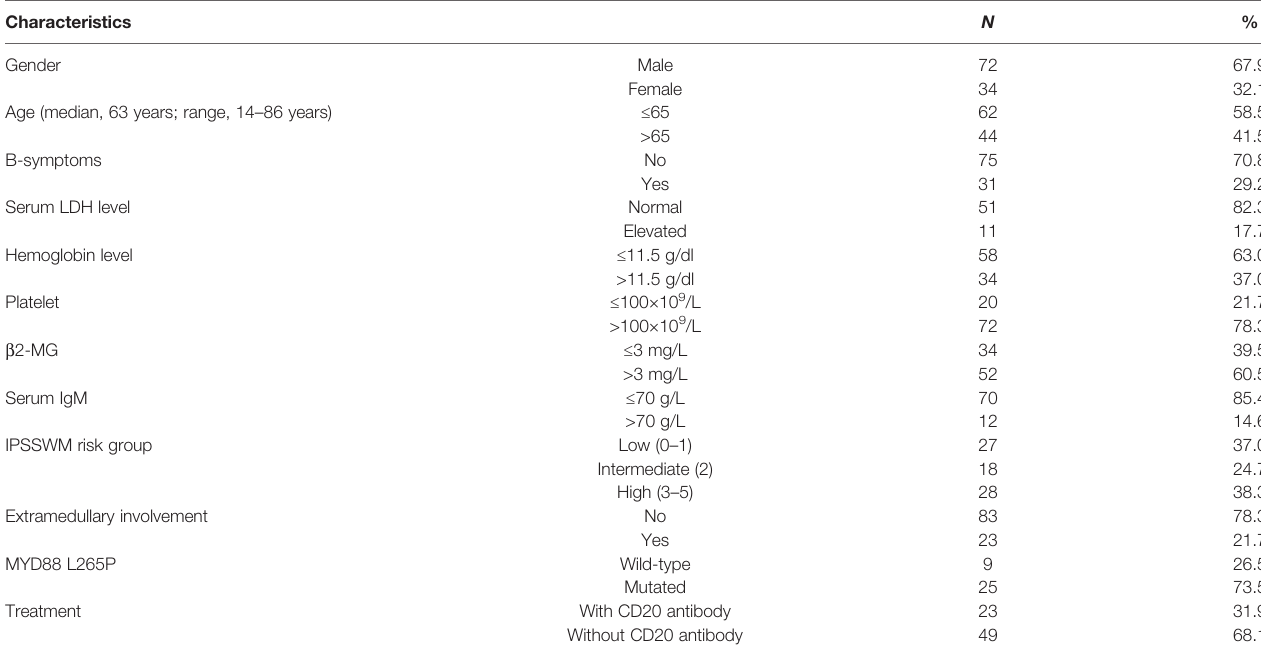
TABLE 1 | Clinical and biological characteristics of Waldenström macroglobulinemia/lymphoplasmacytoid lymphoma (WM/LPL) patients.